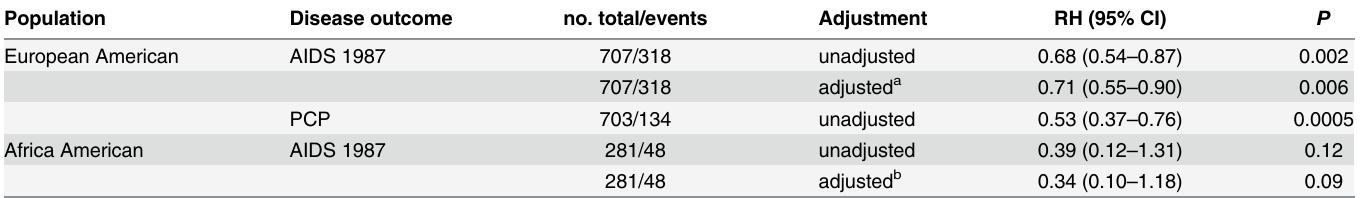
Table 2. Impact of A3F 231V haplotype on AIDS progression assessed by Cox proportional hazards regression model. Population Disease